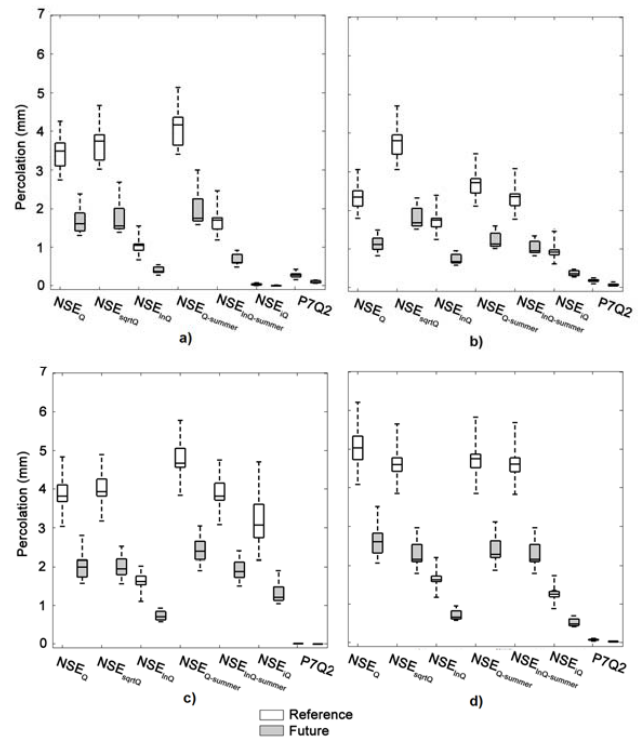
Figure 11. Sum of percolation simulated with the GR4J model for the summer (May to October) for the ( a ) Cowansville; ( b ) Farnham; ( c ) Noire River; and ( d ) St-Hyacinthe sub-watersheds.